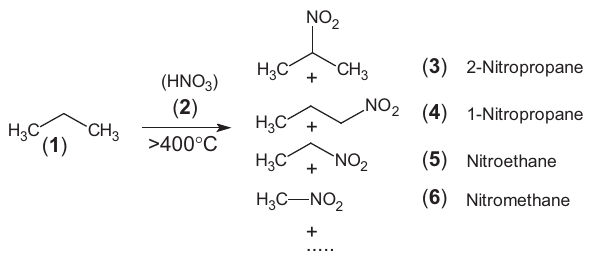
Figure 1 Expected product mixture for high temperature gas-phase nitration of propane. In addition, undisclosed compounds (marked as … ) are formed by C-C bond cleavage and induced reaction of ‧ OH